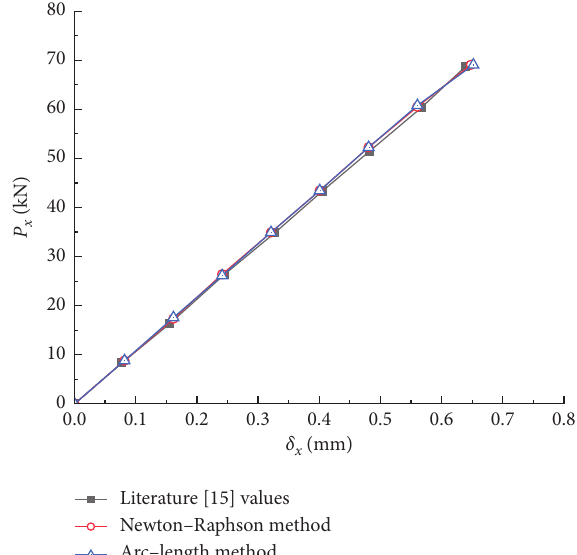
Figure 1: Comparison of axial compression buckling load axial-compression deformation curves of the perfect cylindrical Table 2: Comparison of nonlinear buckling ultimate loads of cylindrical shells with dimple imperfections under axial compression. δ 0 (m) λ (m)